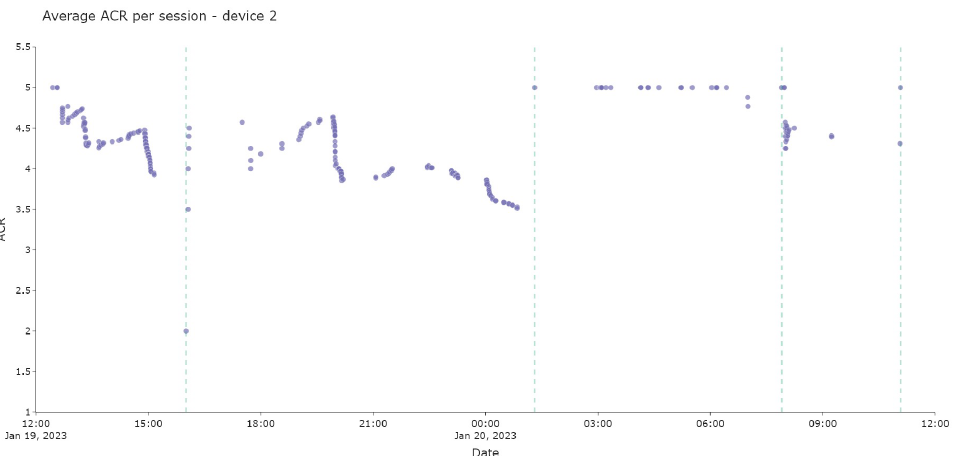
Figure 15. Average ACR grade for entire viewing session for second